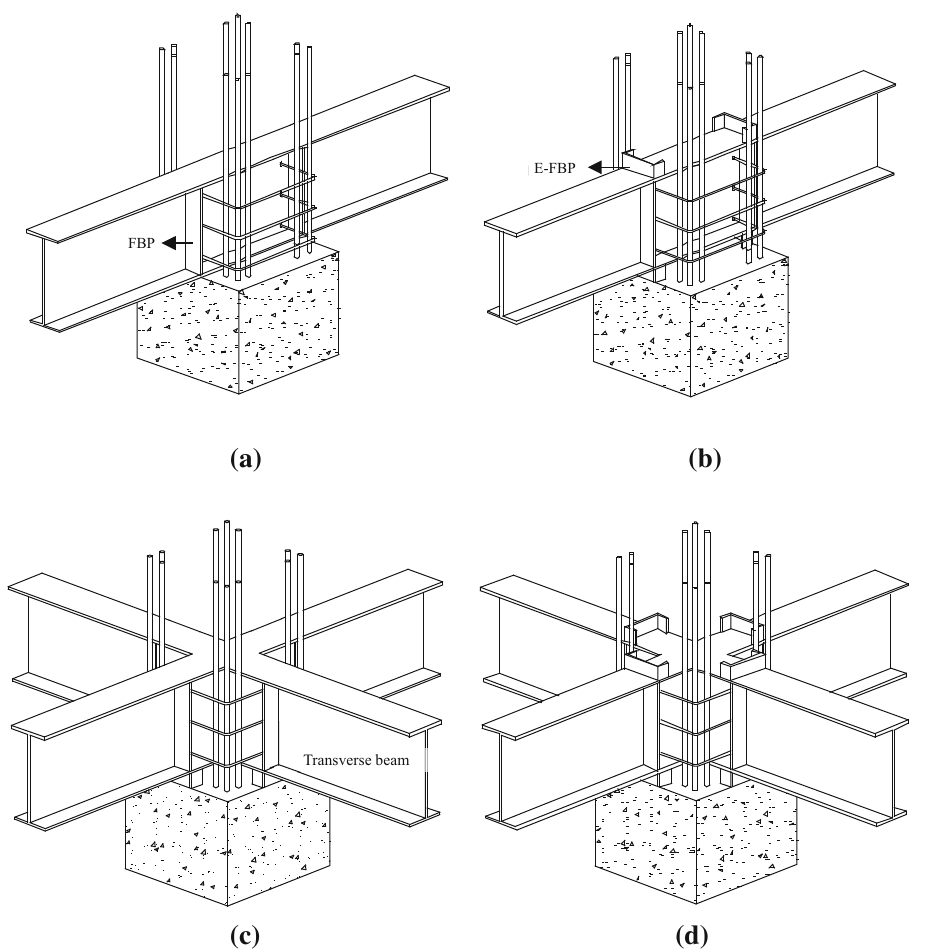
Fig. 4 Connection details for each group: a Group A, b Group B, c Group C, and d Group